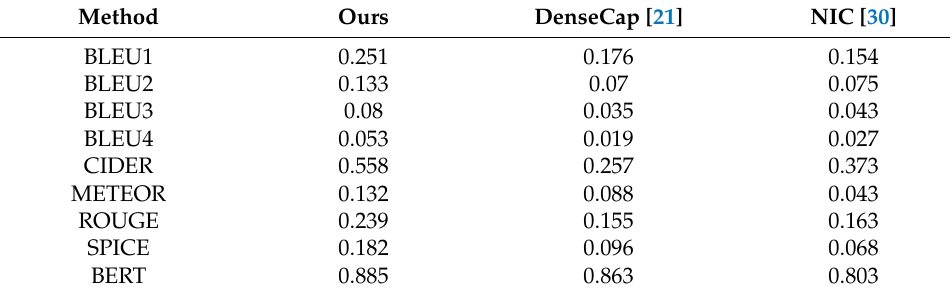
Figure 8. Comparison between our method and [31]. Table 2. Evaluation scores between our method and [21,30].